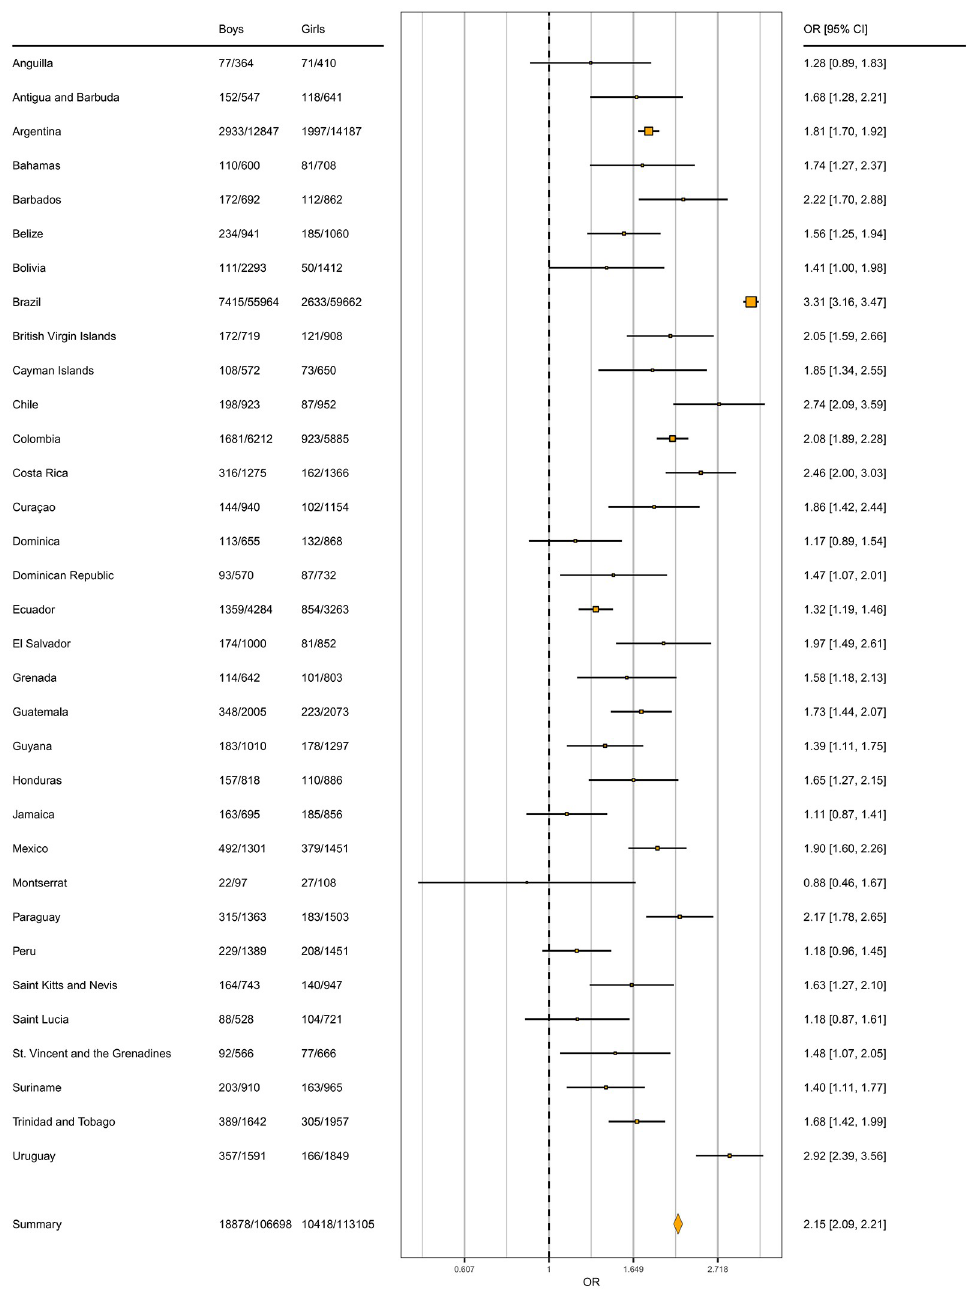
Fig 4. Forest plot showing the odds ratios of meeting international PA guidelines by gender in children and adolescents from Latin-America, by country. Reference = girl.